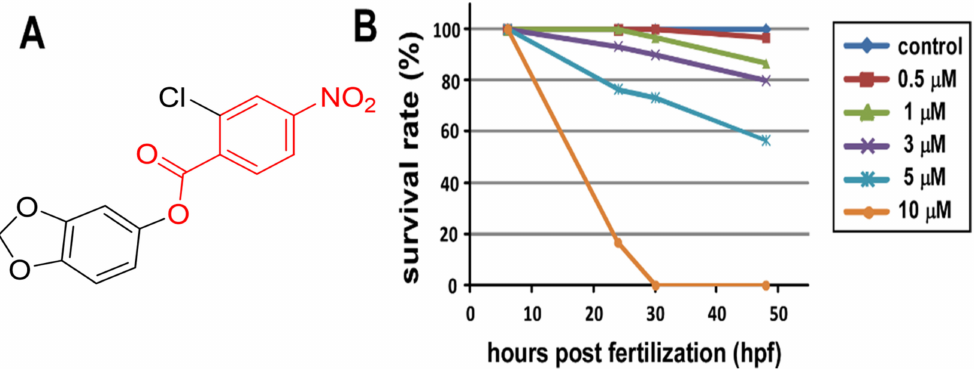
Figure 1. Chemical structure of X8 and toxic effects of X8 on zebrafish embryos . ( A ) The chemical struc- ture of the nitrobe n zoate-derived compound X8 (2 H -13-benzodioxol-5-yl 2-chloro-4-nitrobenzoate) and the molecular weight is 321.7 g/mol. The red color part indicates a nitrobenzoate structure. ( B ) The embryos of wild-type zebrafish were treated (n = 30) with the indicated concentrations of X8 (from 0.5 to 10 µ M) at 6 hpf, and survival rates at 24, 30, and 48 hpf were recorded. The survival rate at 6 hpf was defined as